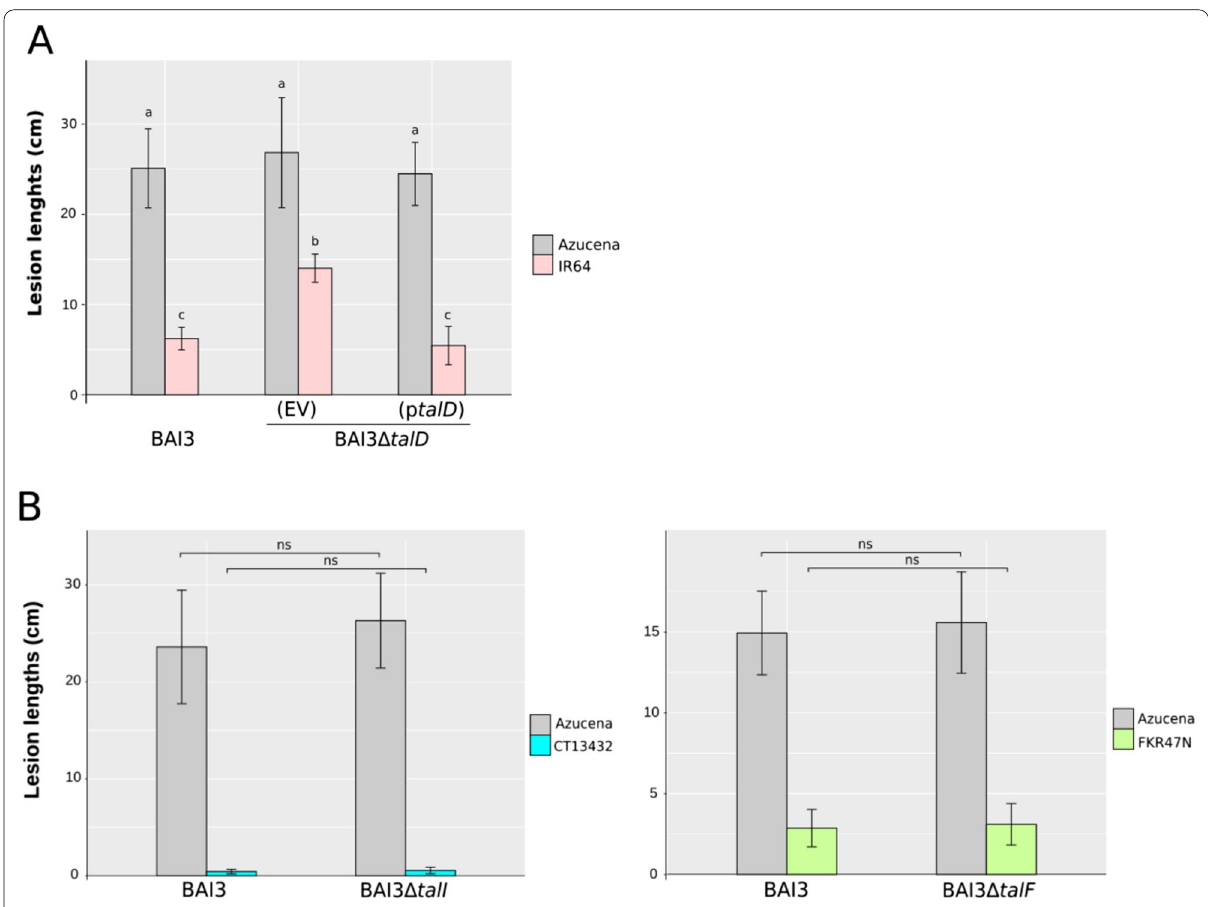
Fig. 1 BAI3∆ talD loses avirulence on IR64 but BAI3∆ talI and BAI3∆ talF do not on CT13432 and FKR47N. A Leaves of IR64 and Azucena were challenged with Xoo strains BAI3, and BAI3Δ talD carrying an empty vector (EV) or a plasmid with talD (p talD) . To assess significance, the parametrical test ANOVA (α 0.05) was carried out using the R package. Values labeled with the same lower-case letter are not significantly = different. B Leaves of rice varieties CT13432, and FKR47N were clip-inoculated with the wild-type African Xoo strain BAI3 and with mutant strains BAI3Δ talI and BAI3Δ talF , respectively. Azucena was included for all strains as a susceptible check. Lesion lengths were measured at 15 dpi. Data are the mean of eight measurements. Error bars represent SD. Significant differences ( p < 0.001) were determined using an unpaired two-sample ± t-test, bars with « ns » are not statistically different. Experiments were repeated three time with similar